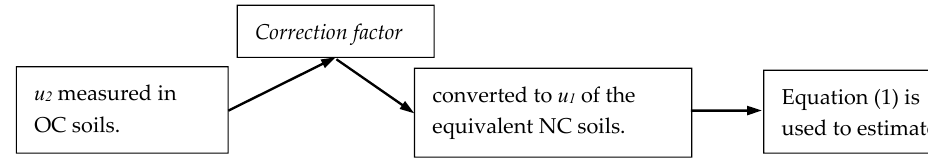
Figure 3. General description of the proposed approach.